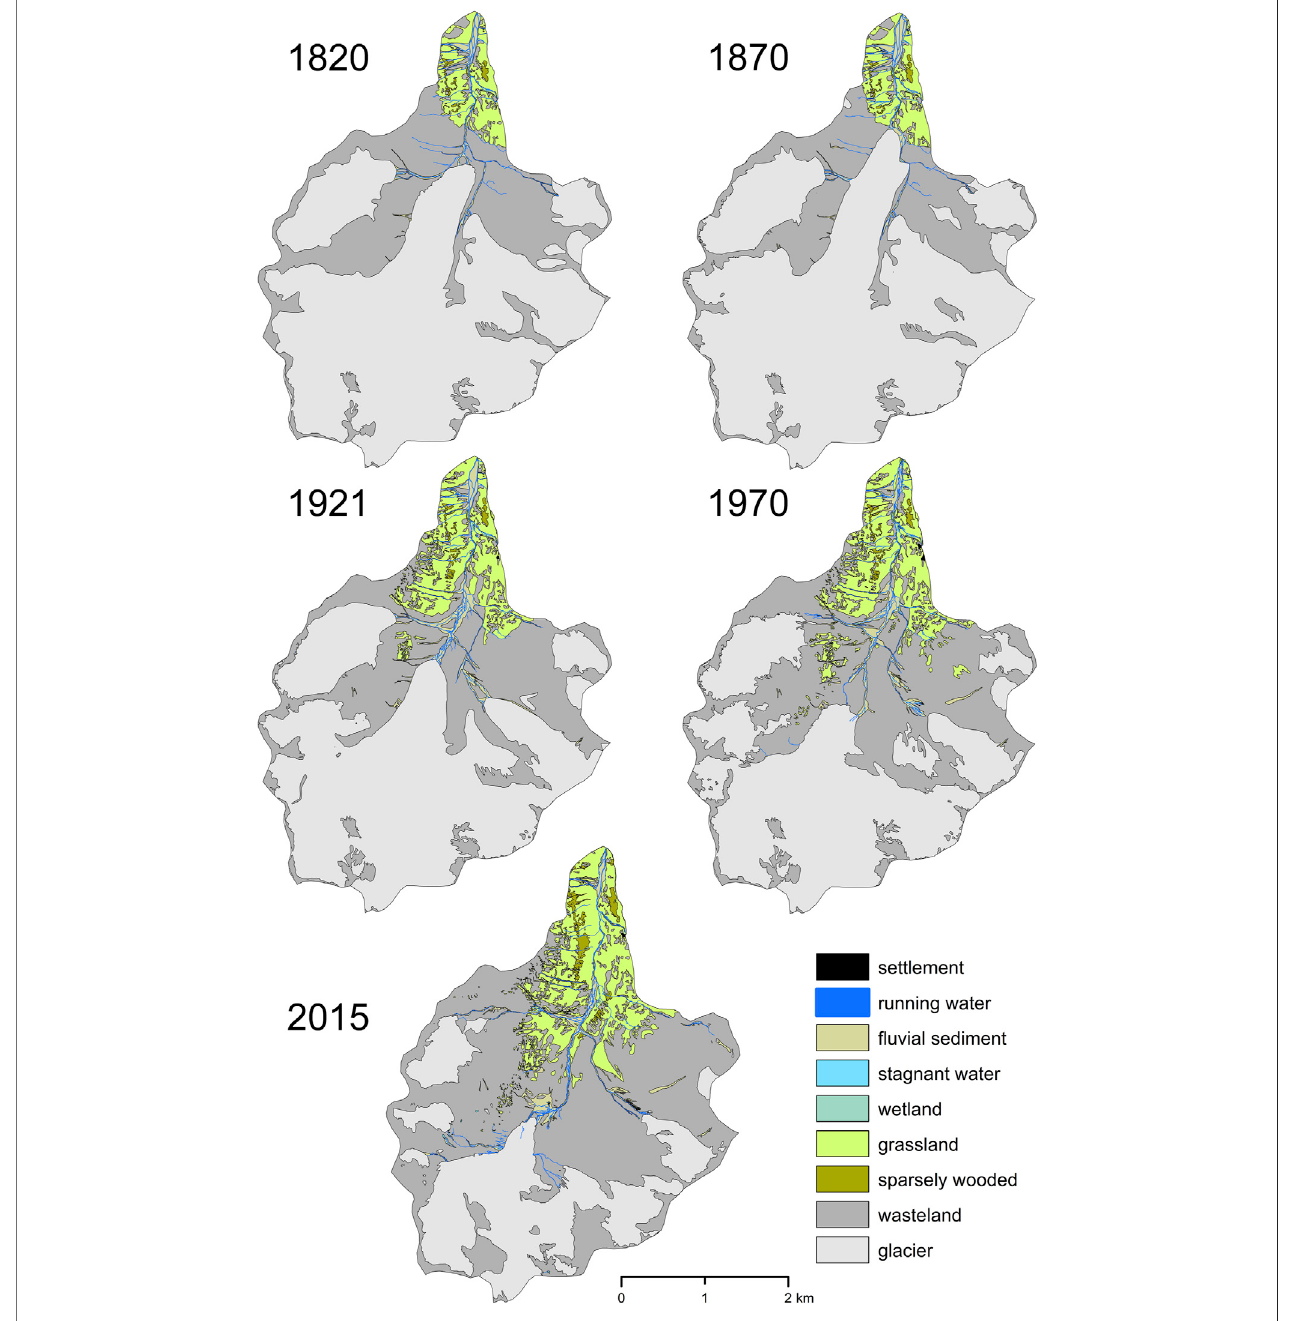
FIGURE4| ReconstructedlandcoverpatternsintheUpperJamtal(Jamtalfernersubbasin:Jamtalfernerglacierandsubjacentvalley fl oor)between1820and2015 (width of running waters is magni fi ed).